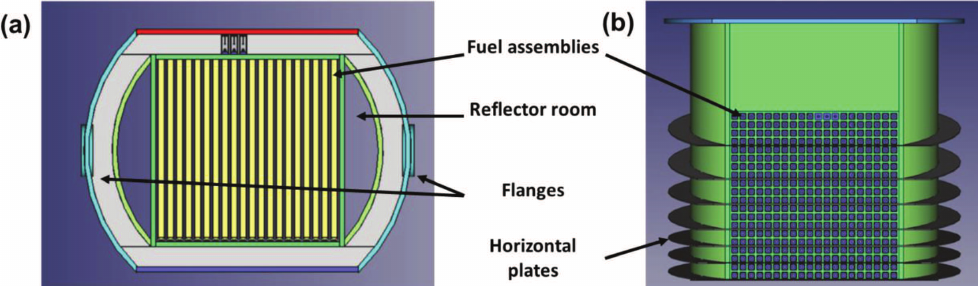
Fig. 5. A sketch to illustrate some basic design principles of reactor core of SCW-SMR: (a) top view of the reactor core; top cover removed; (b) side view onto the head end of the reactor core; front plate and outer cylinder of the reflector removed